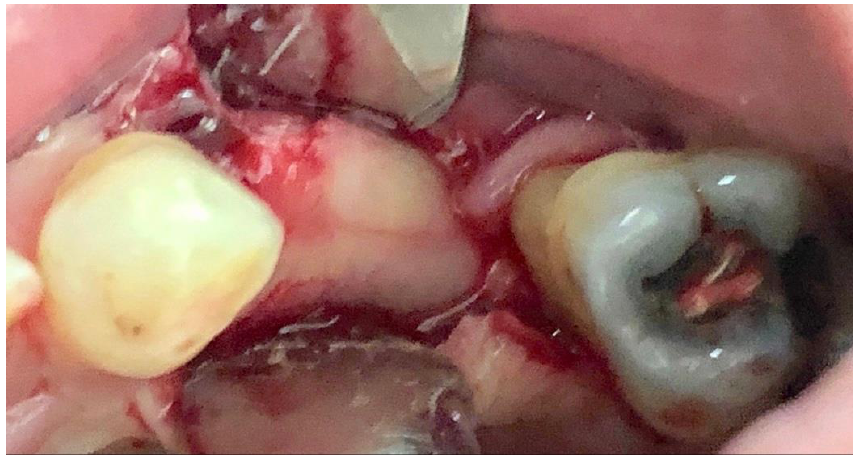
Figure 2. The cortical lamina is shaped to fit the local anatomy and filled with bone graft in order to optimize its space-making effect and ensure no dead space under its surface.